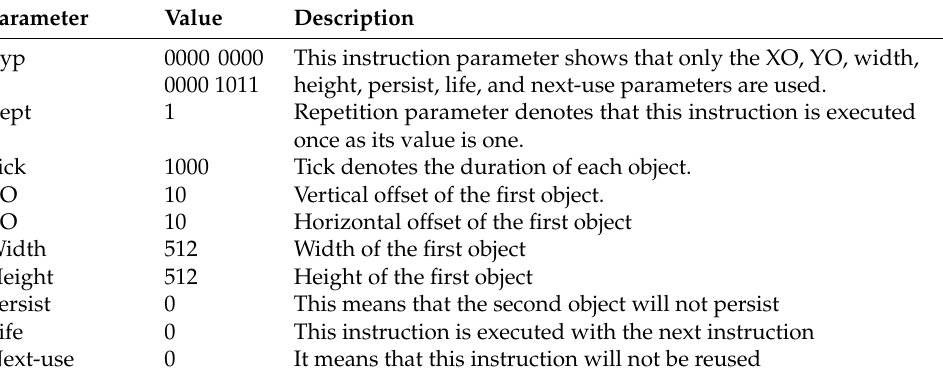
Table A6. Values of the INST parameters.